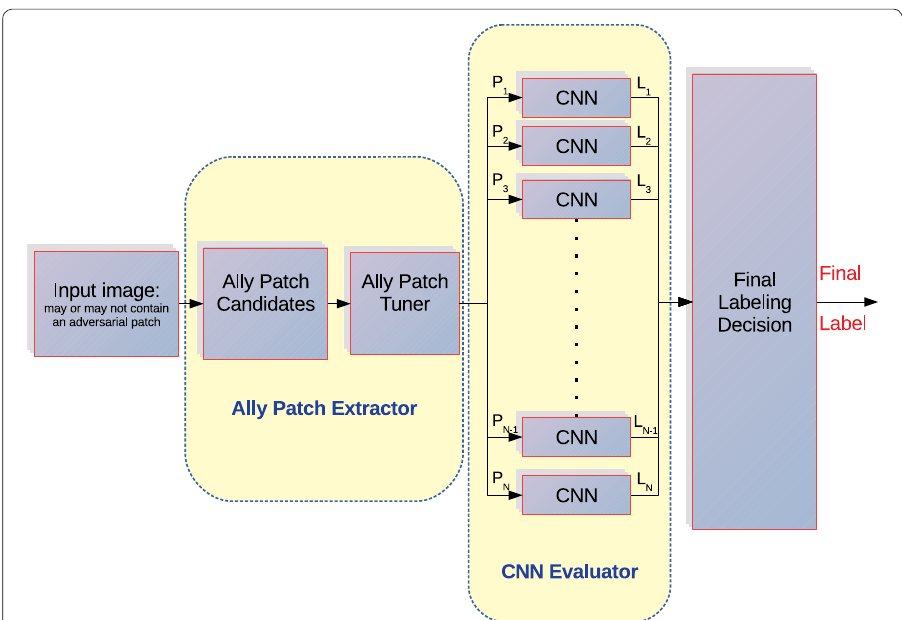
Fig. 3 The block diagram of the entire process of generating ally patches and readjustment of the classification output. The ally patch extractor intrinsically extracts ’promising’ ally patches from the input image. Then identical, yet independent, copies of a pre‑trained convolutional deep network are used to evaluate the classification of each of the ally patches. Finally, the fusion stage decides the most appropriate final label of the entire image. Any possible adversarial patch is counter‑attacked during the ally patch extraction stage. Fled adversarial patches from the evaluator are taken care of in the final